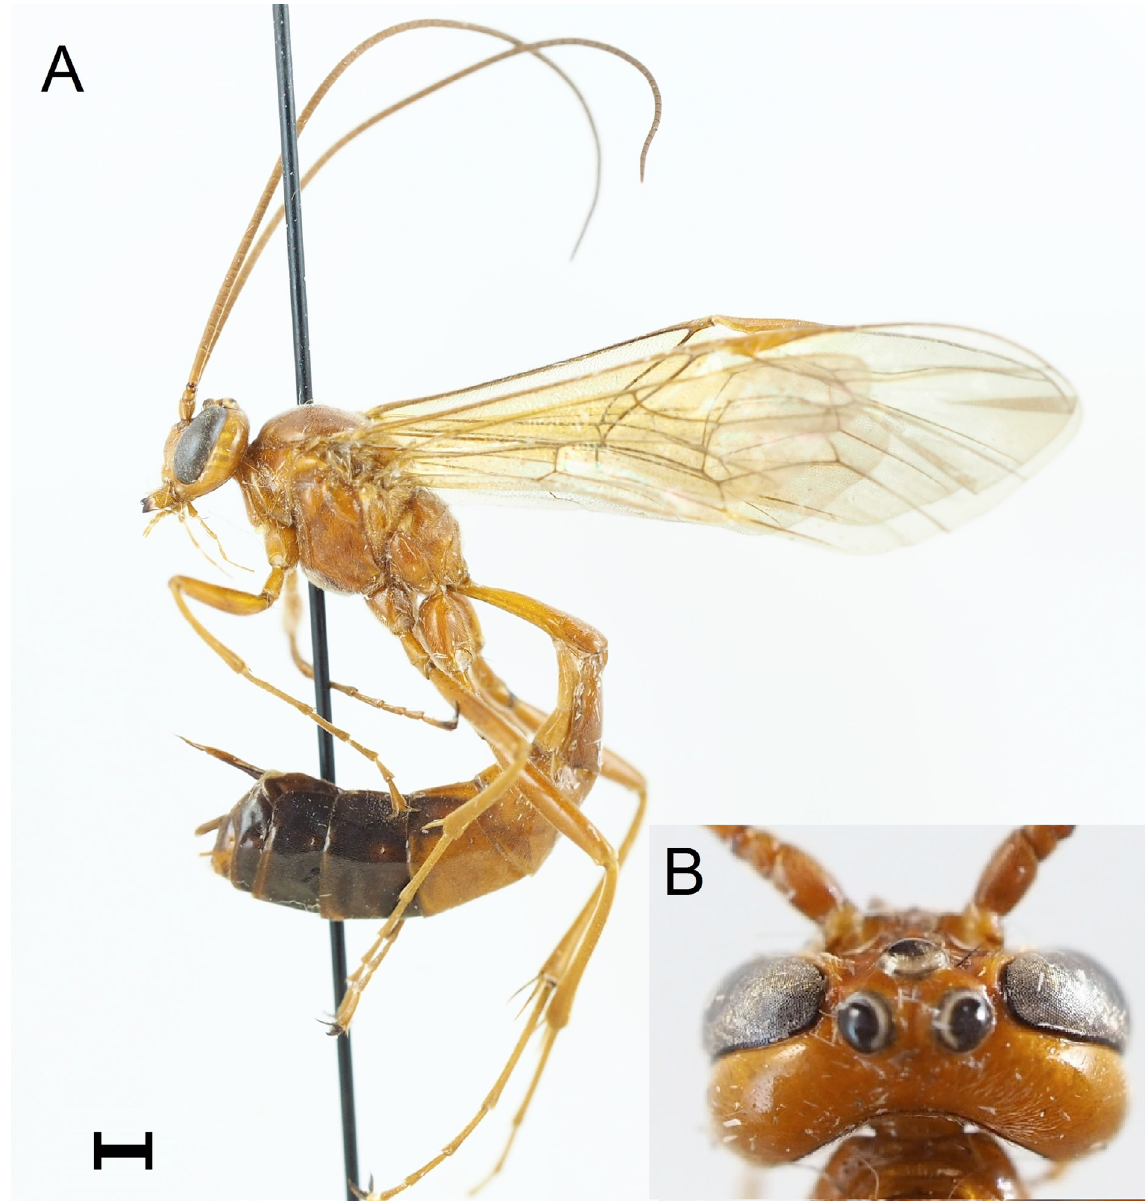
Fig. 35. Ophion longigena Thomson, 1888, ♀. A . habitus, lateral view. B . head, dorsal view. Scale bar: A = 1